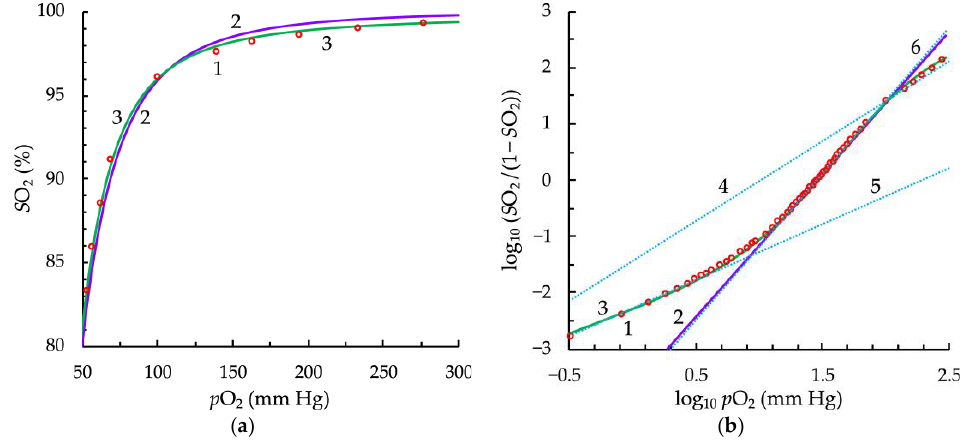
Figure 1. Oxyhemoglobin dissociation curve (ODC): ( a ) linear scale for the x- and y-axes; ( b ) loga- rithmic scale for both the x-axis and y-axis (Hill’s plot); 1, experimental data points for oxygenation curve (from the data set of Winslow et al. [54]); 2, approximation with the Hill’s equation (Hill classic); 3, approximation with the modified Hill’s equation (Hill/L); 4, 5, dotted lines correspond to asymptotes, which are not exactly parallel, but with slopes very close to one; 6, the dotted line is tangential to the point p 50 ; axes: p O 2 , partial pressure of oxygen; S O 2 , oxygen saturation.